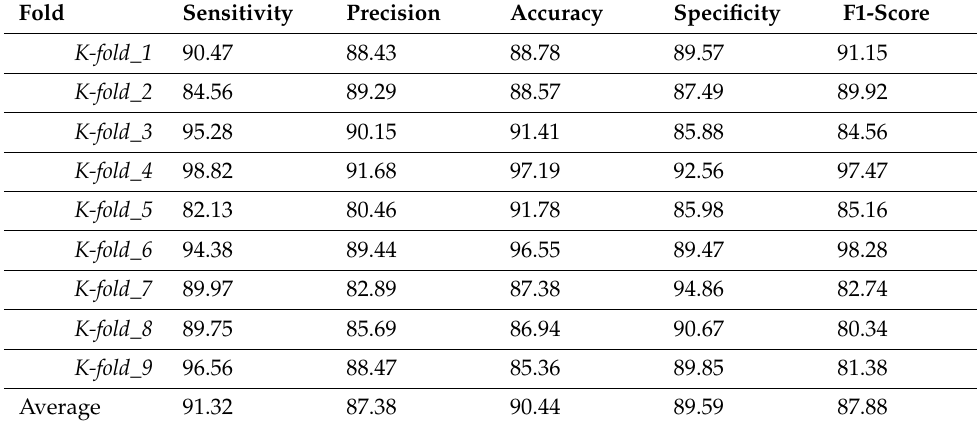
Table 3. Evaluation of Baresnet model performance metrics.